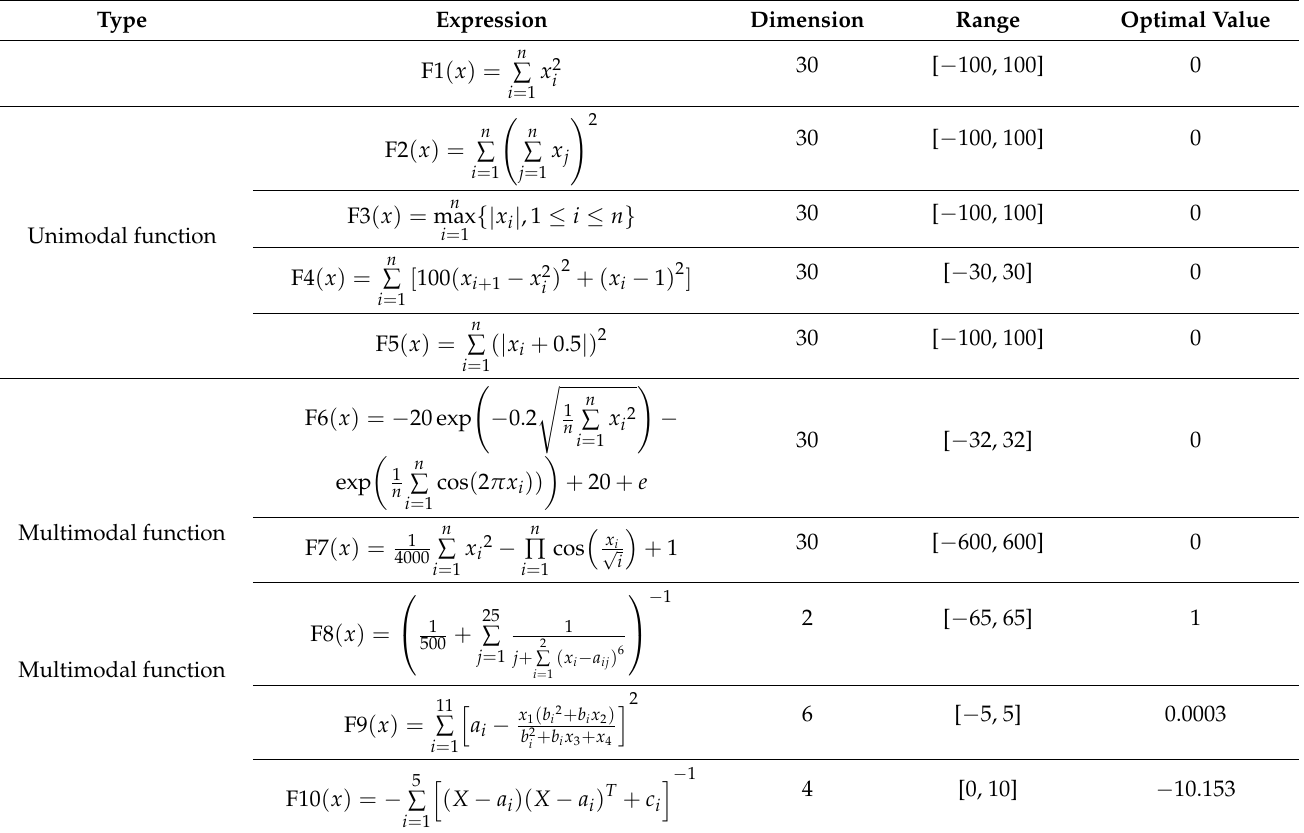
Table 1. Benchmark